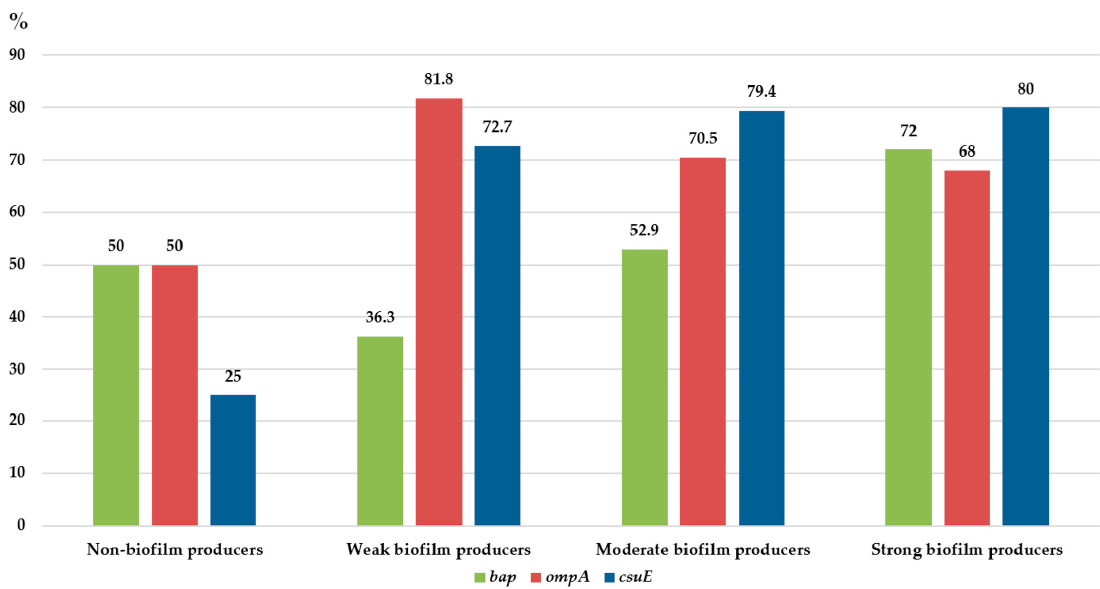
Figure 1. The percentage of gene-encoding biofilm-associated proteins among biofilm-producing and non-biofilm-producing carbapenem-resistant Acinetobacter baumannii ( n = 111) .